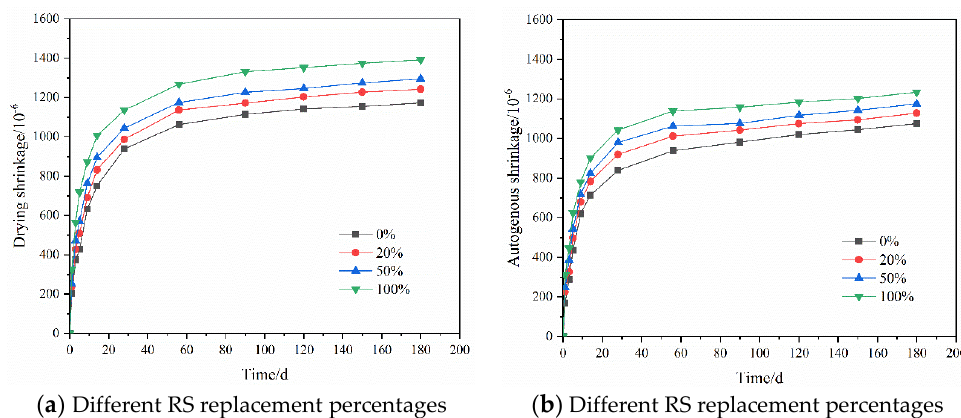
Figure 2. Effect of the RS replacement percentage on the shrinkage of mortar: ( a ) Drying shrinkage; ( b ) autogenous shrinkage.